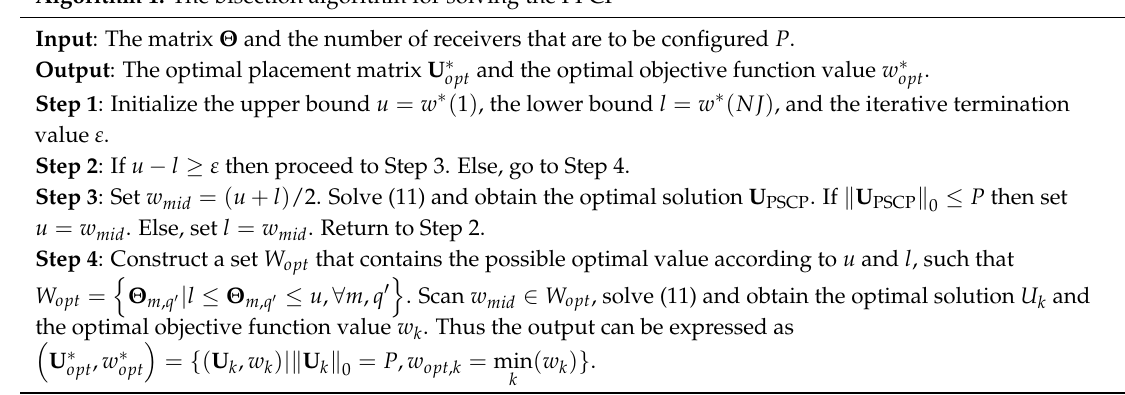
Algorithm 1: The bisection algorithm for solving the